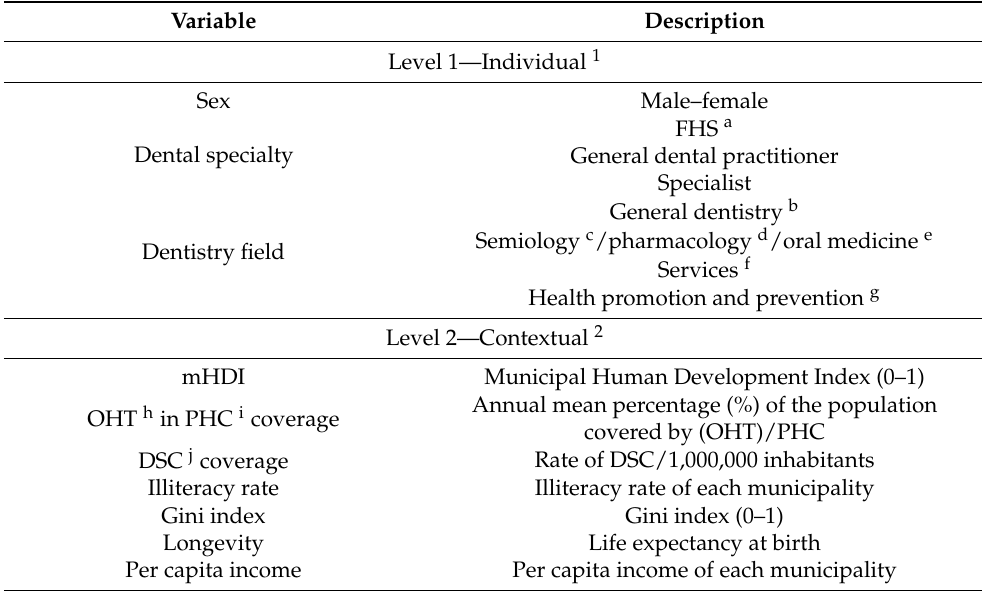
Table 1. Description of each independent variable by level of analysis from dental teleconsulting